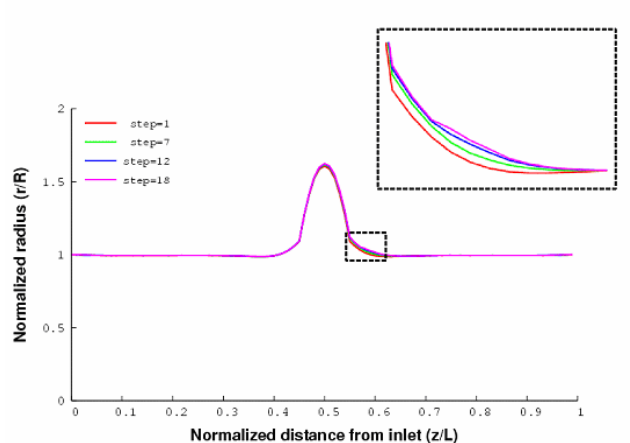
Fig. 4 Plot of the growth of aneurysm for the straight model. Simulation condition: k=1.5 =50 dyne/cm 2 (5.0 Pa). and τ th The WSS distribution is shown in Fig. 5, where high WSS can be observed at the distal neck of the aneurysm. The inside of the aneurysm is dominated by low WSS. There are also